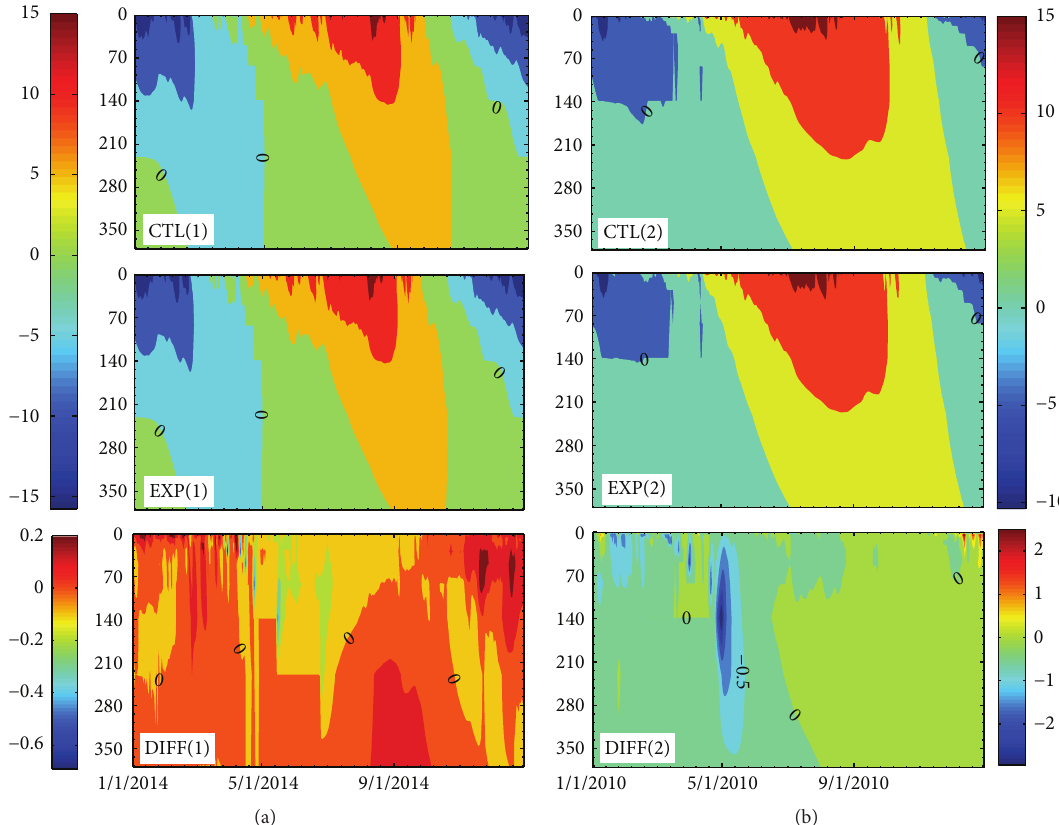
Figure 6: Profile of soil temperature differences (CTL minus EXP) at (a) GS and (b) ZS site.